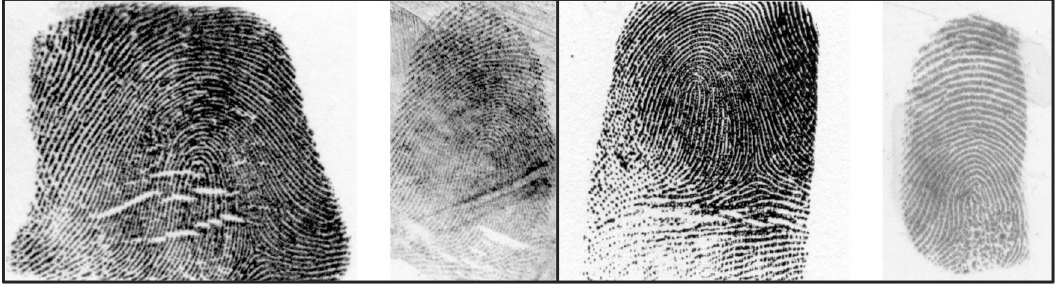
Fig 2. Example match (left panel) and non-match (right panel) trials between exemplar (left image in each example) and latent (right image in each example) fingerprints.